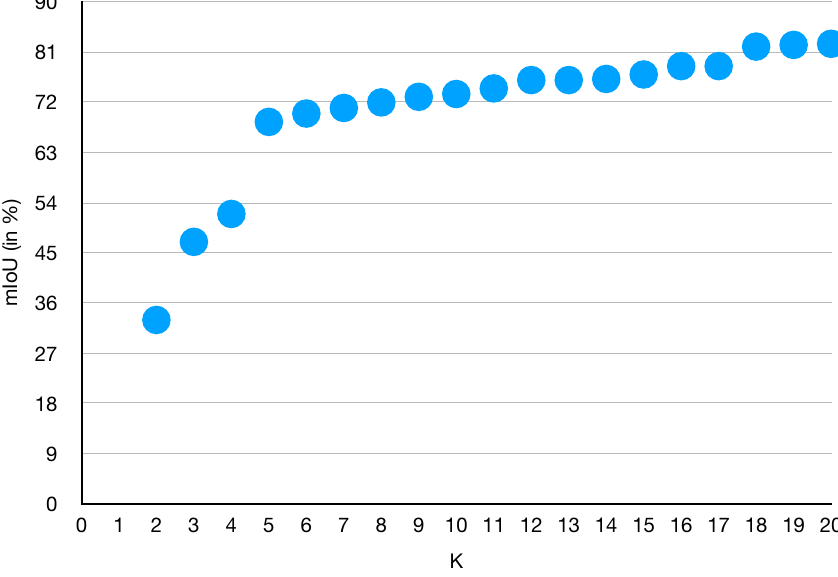
Figure 11. The relationship between the number of clusters K and model